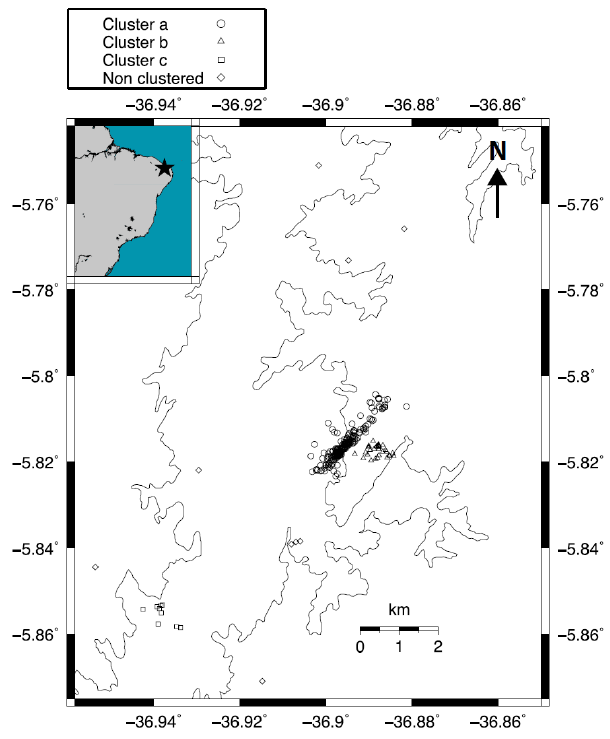
Fig. 1. Spatial distribution of the seismic clusters a, b and c in Ac¸u (NE